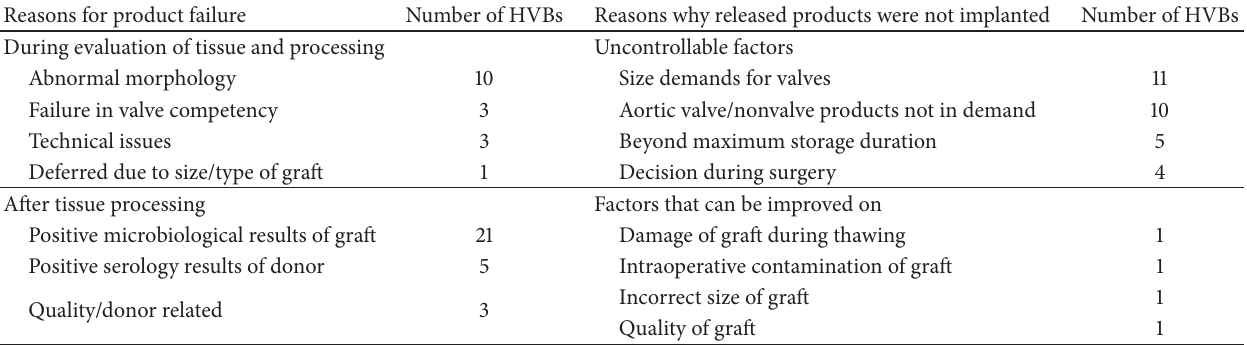
Table 11: Reasons for product failure and why released products were not